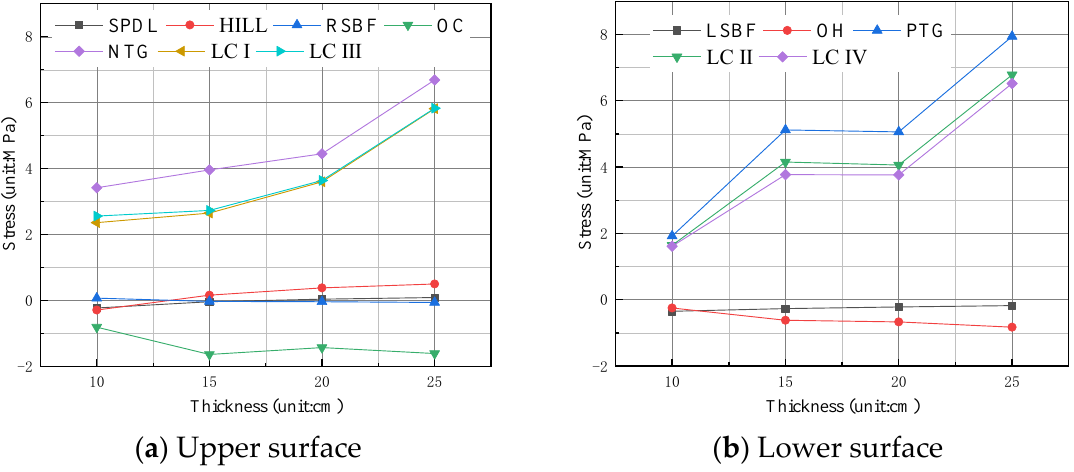
Figure 15. The curve of maximum principal tensile stress vs. thickness of CLS with concrete pave- ment.